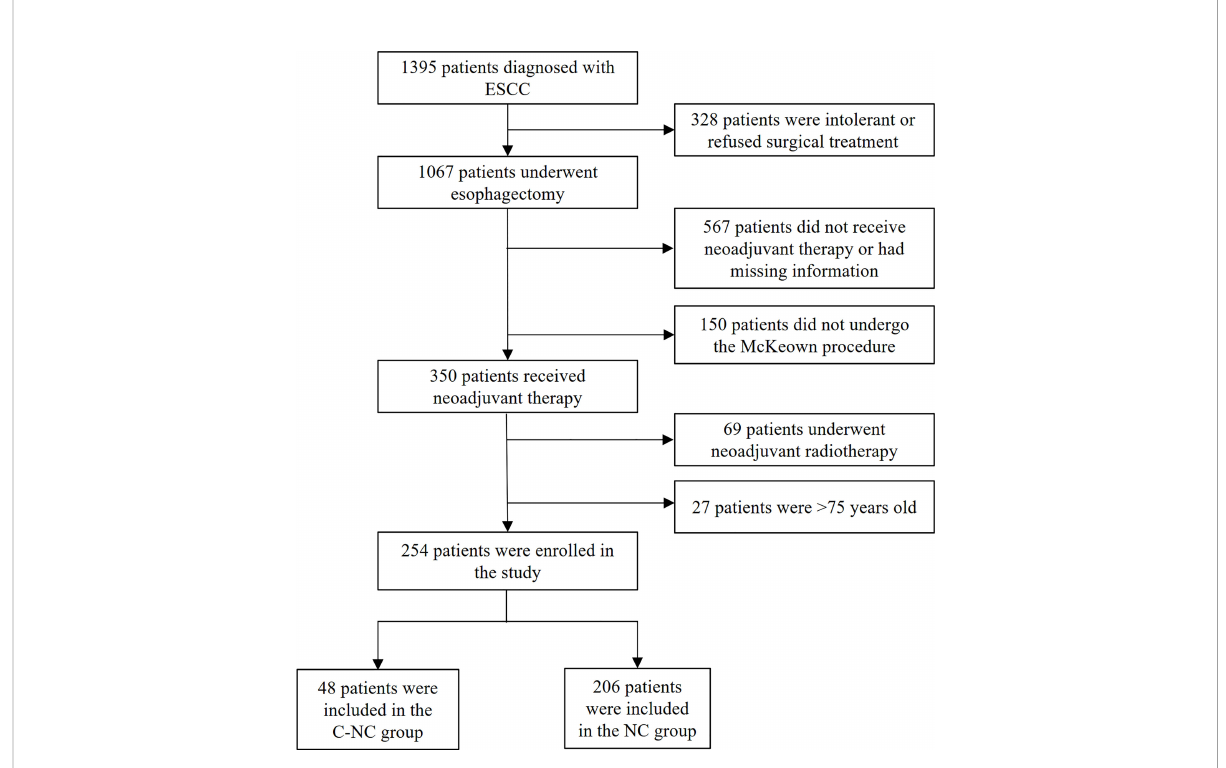
FIGURE 1 The participant selection